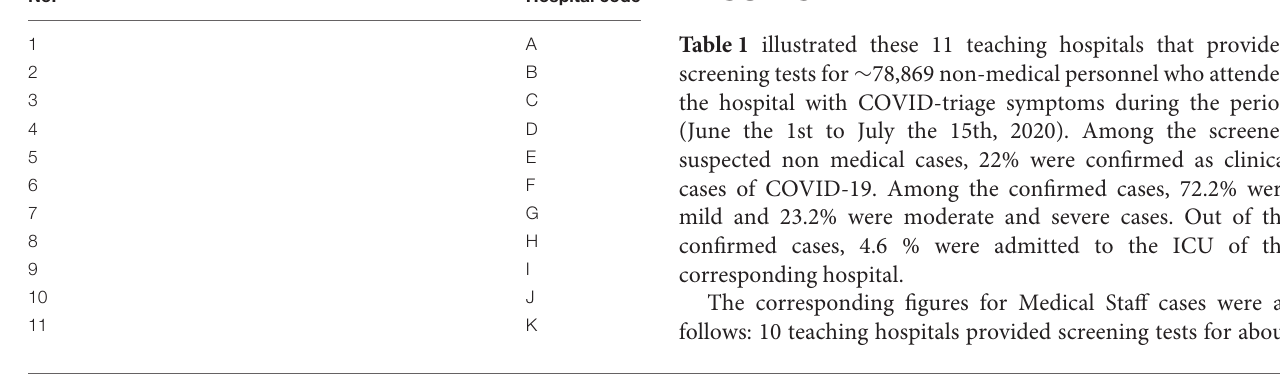
TABLE 1 | The percentage of PCR confirmed COVID-19 cases among total suspected cases presented with COVID-19 symptoms to teaching hospitals (June 1st to July 15th, 2020).